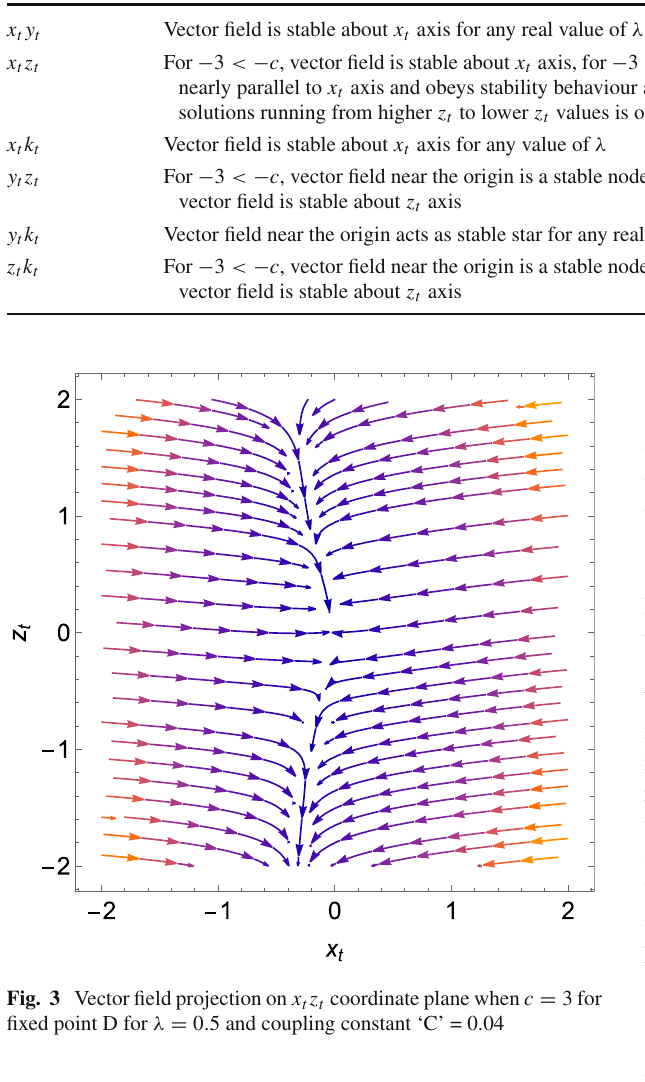
Table 3 Stability properties of vector field for critical point D Coordinate plane Stability